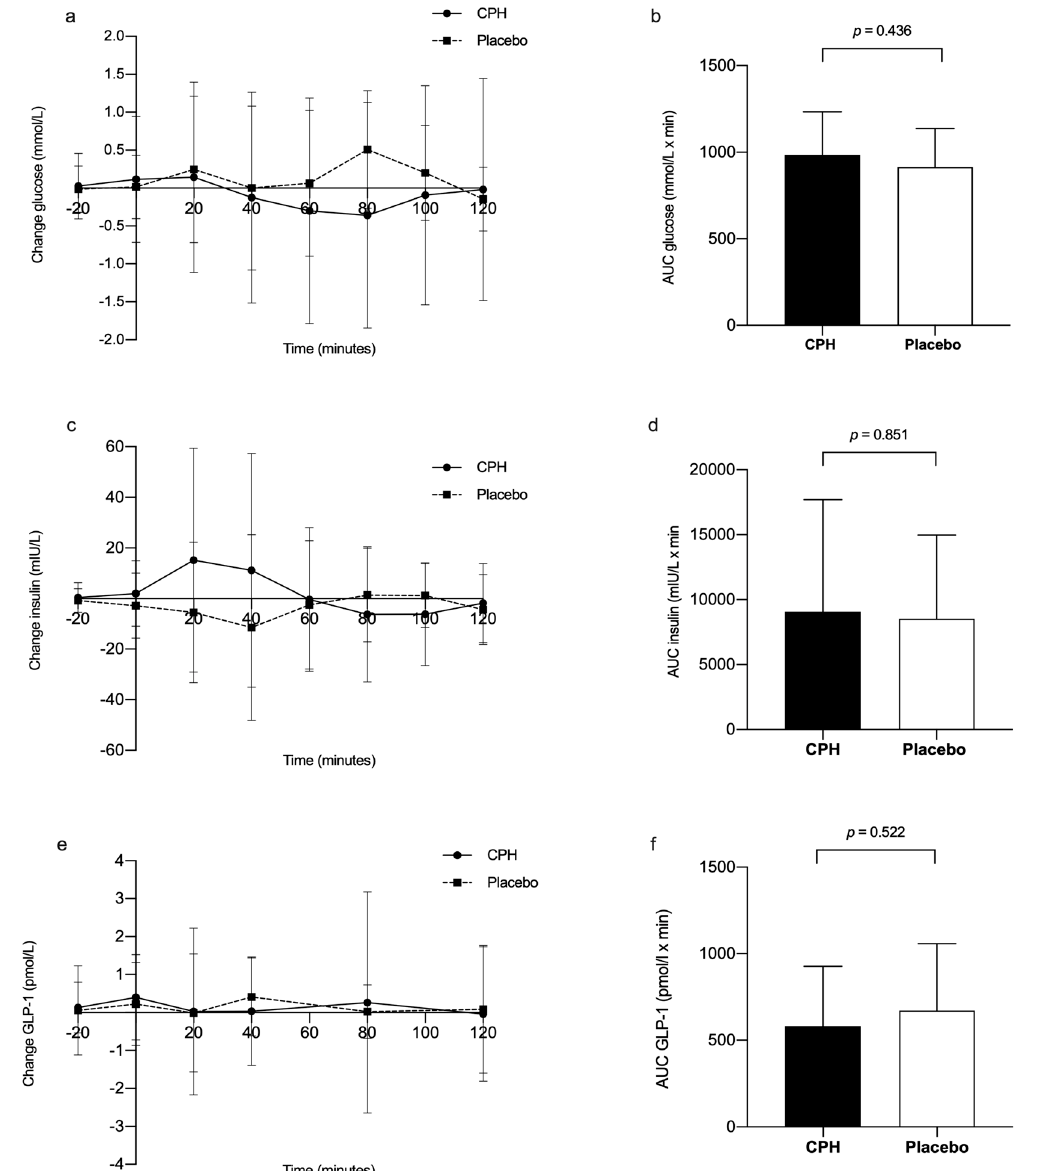
Figure 2. Glucose, insulin and glucagon-like peptide 1 (GLP-1) response in subjects with metabolic syndrome supplemented with cod protein hydrolysate (CPH) ( n = 15) or placebo ( n = 15) for 8 weeks. Change (8 weeks – baseline) in ( a ) serum glucose, ( c ) insulin and ( e ) plasma GLP-1 after a standardized breakfast meal, comparing the CPH group (solid line) with the placebo group (stippled line). The first postprandial blood samples (= 0 min) were taken 15 min after the test meal was served. For two individuals in the placebo group, only the fasting levels are included in the graphs. The area under the glucose curve ( b , AUC glucose), insulin curve ( d , AUC insulin) and GLP-1 curve ( f , AUC GLP-1) for the CPH group (black bar) vs. the placebo group (white bar) at end of study. Values are presented as the mean ± SD.